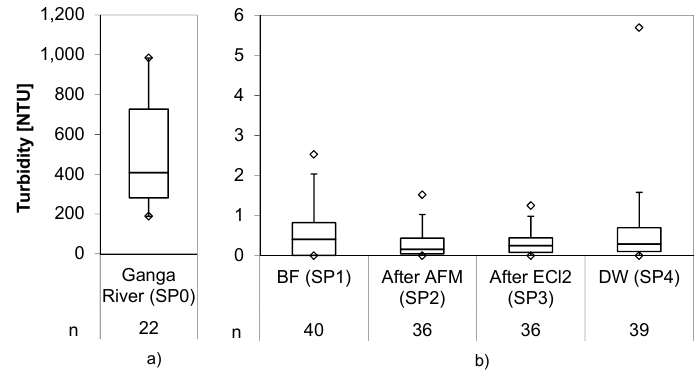
Figure 4. Turbidity values along water treatment.